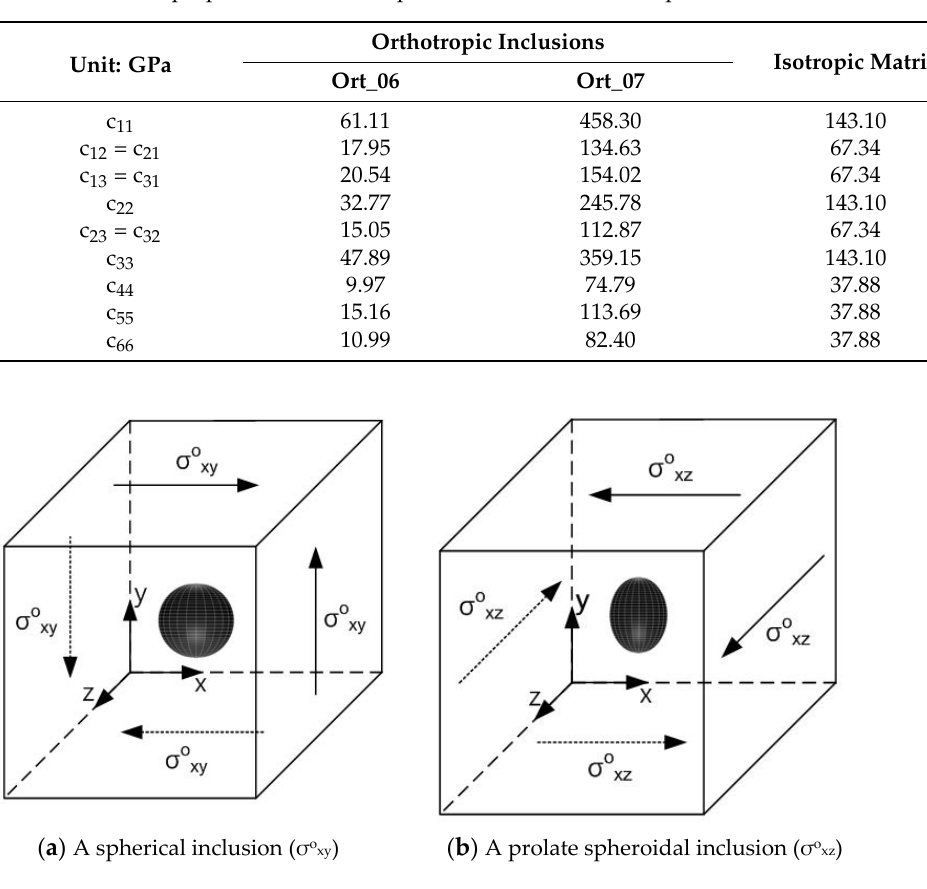
Table 4. Material properties of the isotropic matrix and the orthotropic inclusions.